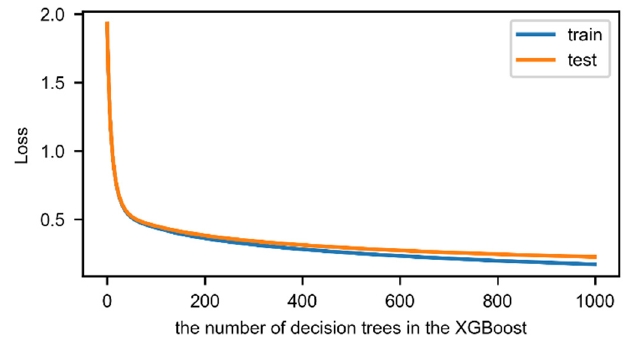
Figure 14. Effect of the number of decision trees on the loss of XGBoost in the proposed method.